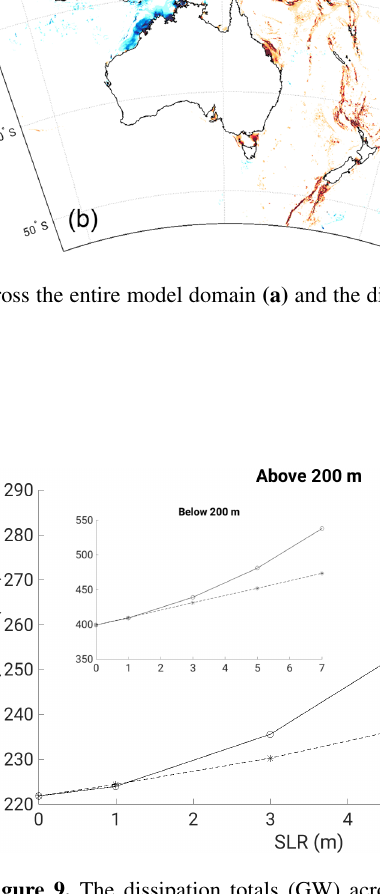
Figure 9. The dissipation totals (GW) across the model domain above and below (inset) the depth of the 200m isobath of the control